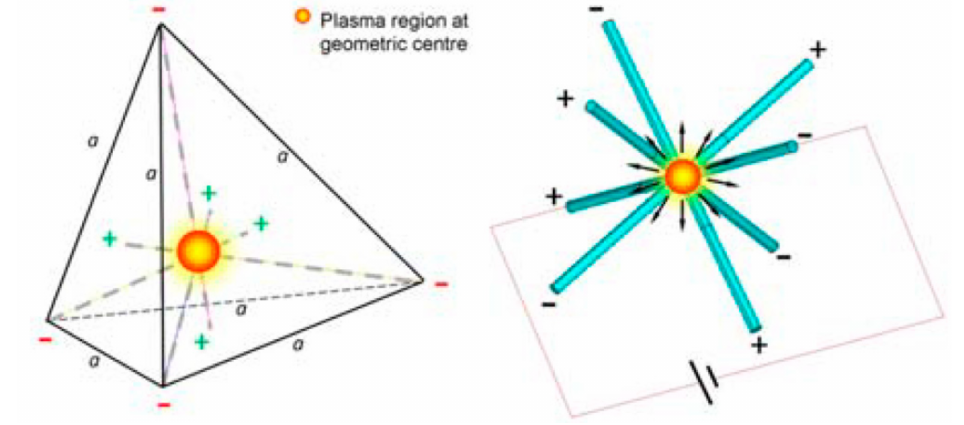
Figure 1. Multi-Beam Pinch